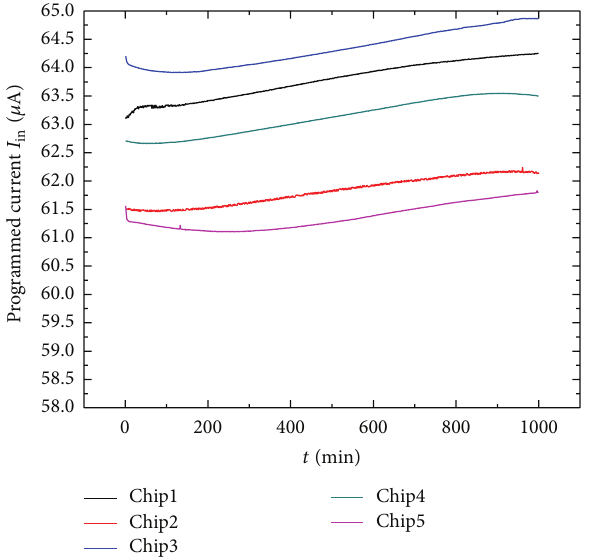
Figure 10: Output current 𝐼